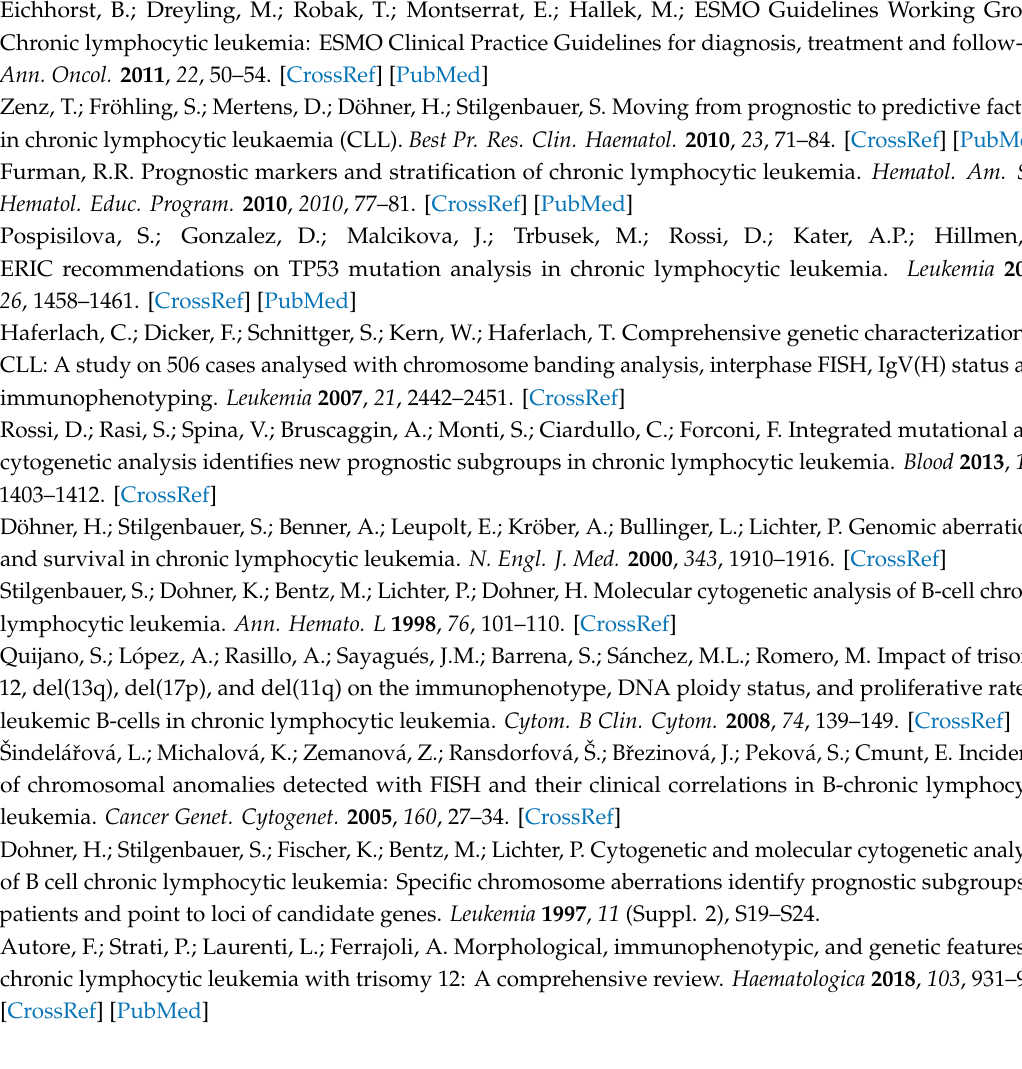
Table S1: Multivariate analysis in + 12 CLL patients (Cox regression analysis); Table S2: Multivariate analysis in negative FISH CLL patients (Cox regression analysis); Table S3: Baseline characteristics of the validation cohort; Table S4: Baseline characteristics of the validation cohort CLL patients with + 12 divided in two subgroups according to LDH levels; Table S5: Multivariate analysis in validation cohort patients (Cox regression